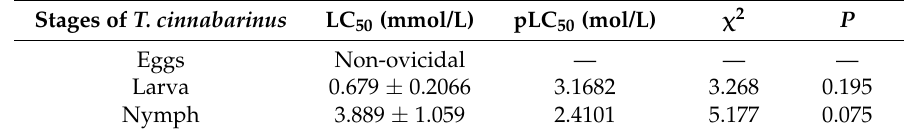
Table 2. Acaricidal activity of compound 8 against eggs, larvae, and nymphs of T. cinnabarinus (48